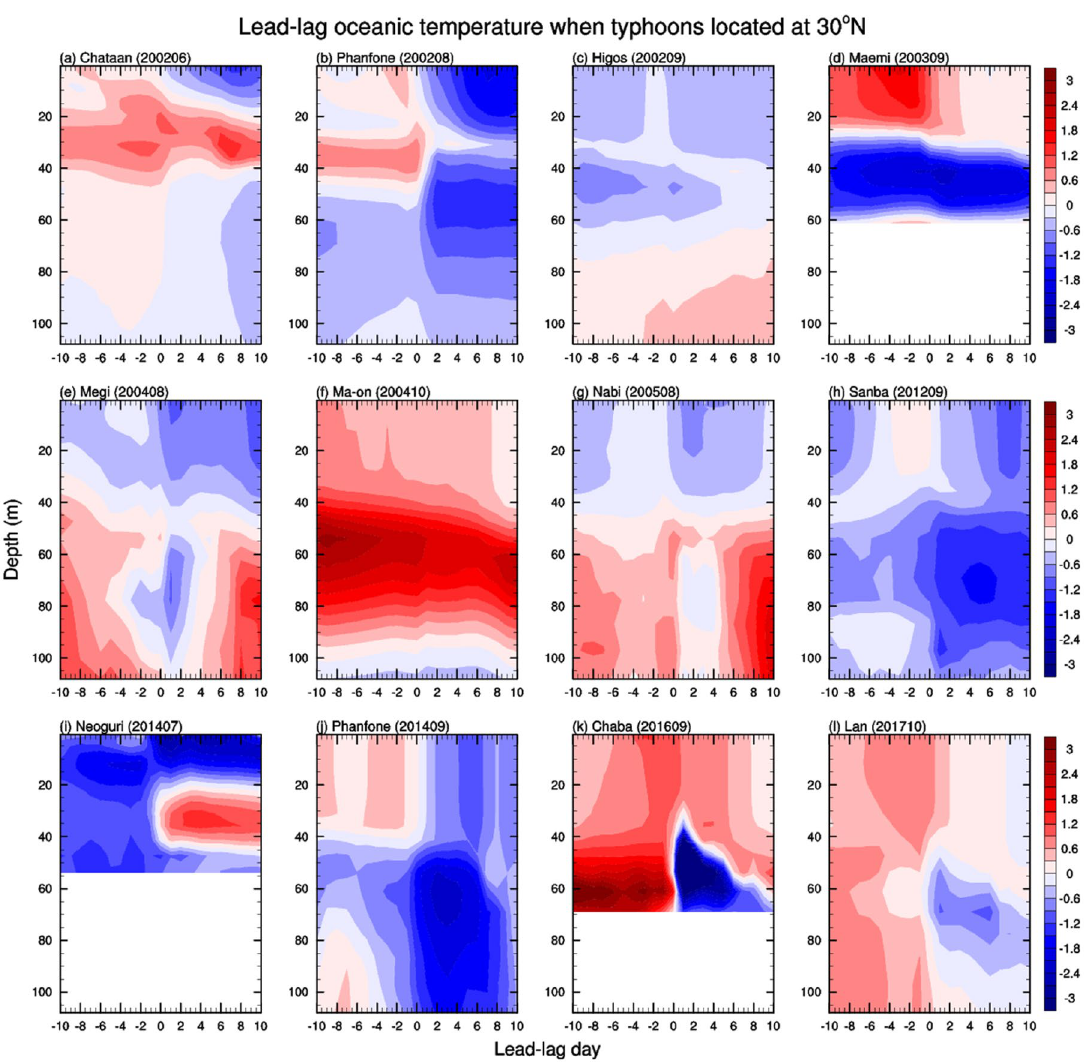
Figure 3. Lead-lag vertical profiles of the temperature anomaly with respect to typhoon arrival day. When typhoons were located at 30°N, the vertical profiles were plotted from -10 to 10 days for 12 individual typhoon